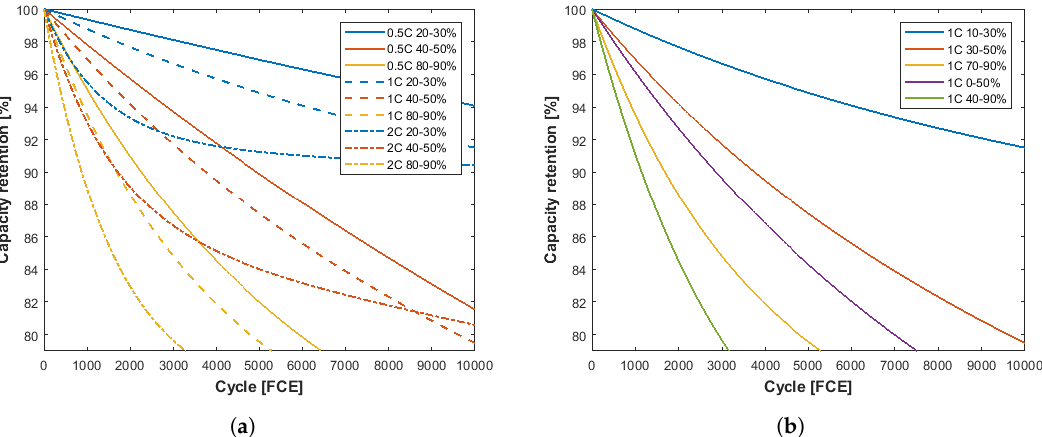
Figure 8. Model result at 30 ◦ C starting at different SOC levels in ( a ) 10% Depth of Discharge (DOD) with 0.5C, 1C and 2C; and ( b ) 20% and 50% DOD with